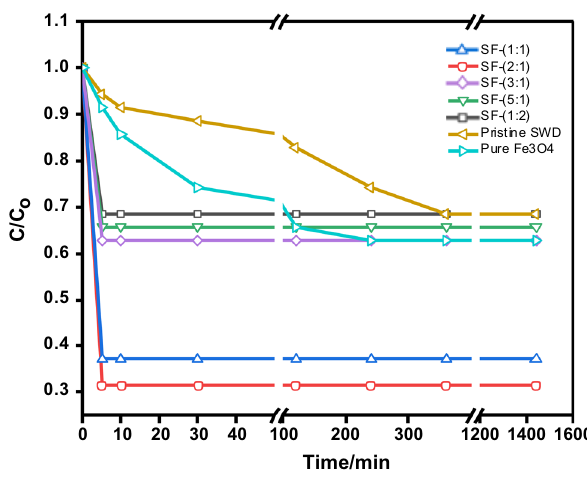
Fig. 6 Effect of isotherm time on the dye removal using various